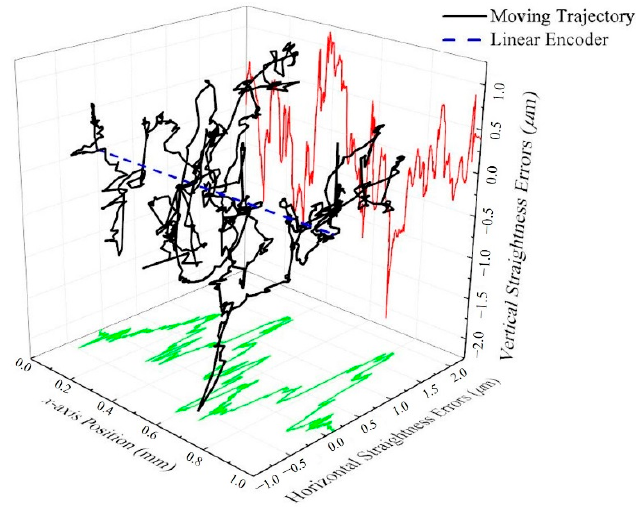
Figure 9. Straightness error measurement test results.